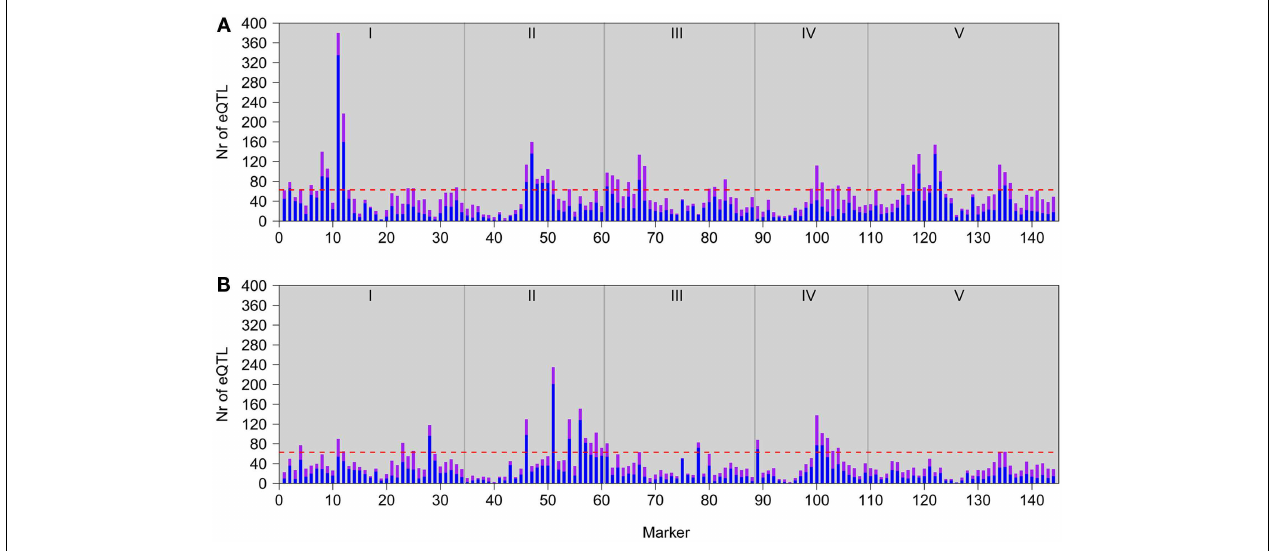
position.The horizontal red lines represent the significance threshold values for defining a hotspot. Gray vertical lines depict chromosomal borders, chromosomes (I–V) are indicated at the